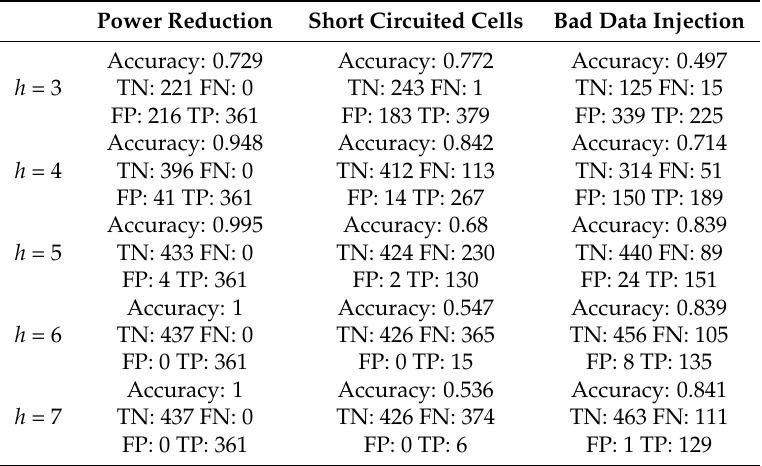
Table 2. Impact of the choice of the threshold on